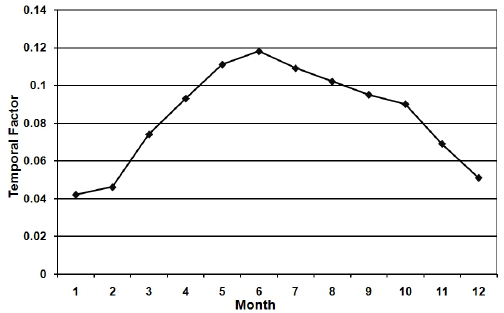
Table A2. Sulfur emissions factors for geothermal sources.